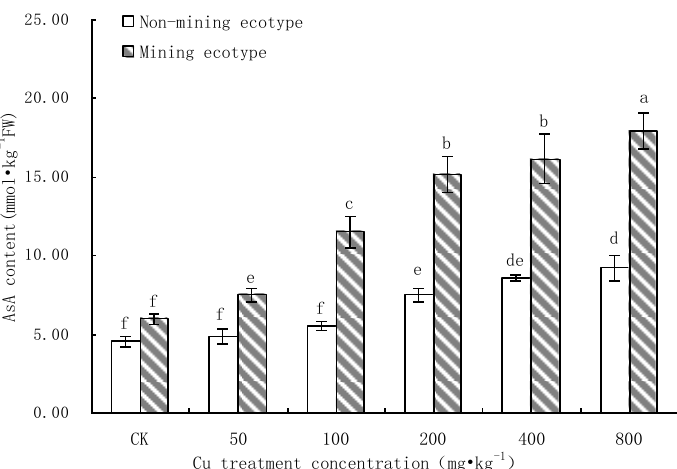
Figure 4. AsA concentrations of two ecotypes of M. floridulus under different Cu treatment. Note: Error bars indicate standard deviation; Different letters in the same group indicate significant difference at p < 0.05 according to Duncan’s multiple range tests; the same below.